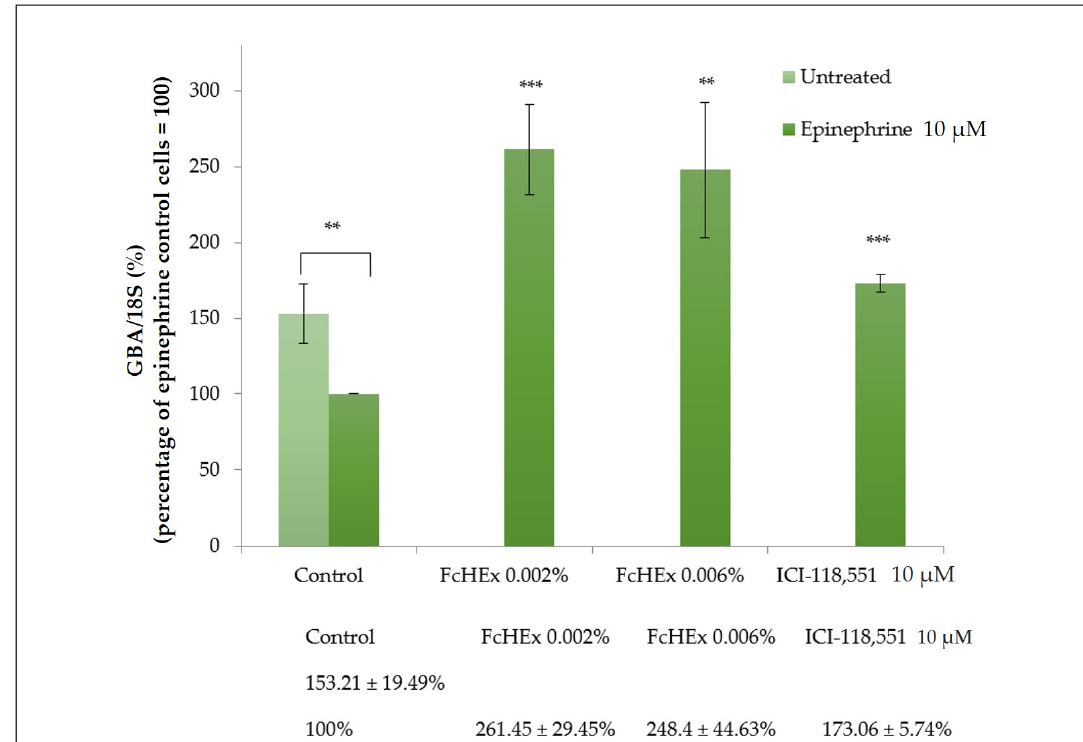
Figure 7. Effect of the FcHEx on the β -glucocerebrosidase (GBA) enzyme gene expression in the skin keratinocytes. The keratinocytes were stimulated with 10 µ M of epinephrine alone or with the FcHEx or the positive control for 4 h and then processed for RT-PCR analysis. The reported values represent the averages of three independent experiments and are expressed as the percentages of cells treated with epinephrine only, which was set to 100%. The asterisks indicate statistically significant values (*** p -value was between 0.0001 to 0.001; ** p -value was between 0.001 to